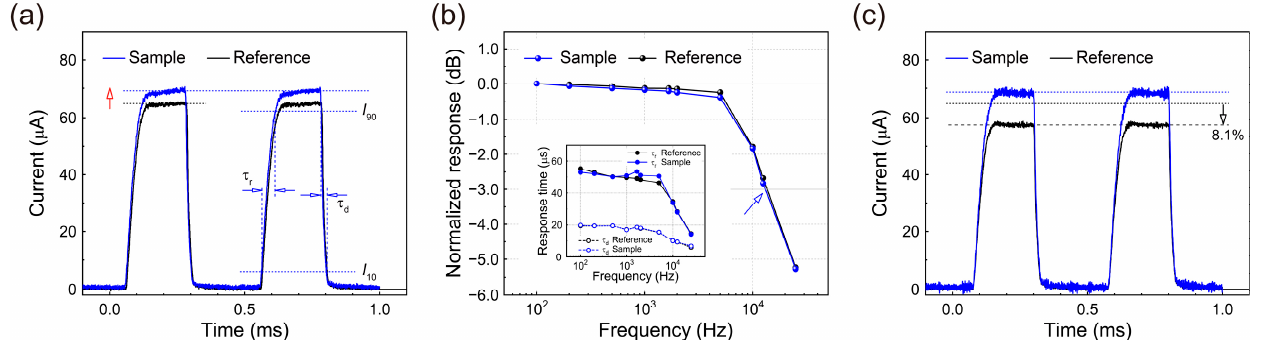
Figure 5. ( a ) Temporal photo responses of the reference and sample MAPbI 3 photodiodes at zero bias voltage when turning the incident light ( λ = 637 nm, P = 190 μ W) on and off (2 kHz). The rise ( τ r ) and decay ( τ d ) times were determined as the time intervals between the 10% ( I 10 ) and 90% ( I 90 ) amplitude levels of the signal, respectively. ( b ) Normalized photocurrent versus the modulation frequency of incident light ( p = 190 μ W, 637 nm). The inset shows the dependences of τ r and τ d on the modulation frequency for the photodiodes studied here. ( c ) Temporal photo responses of the reference and sample photodiodes when stored for 500 h.